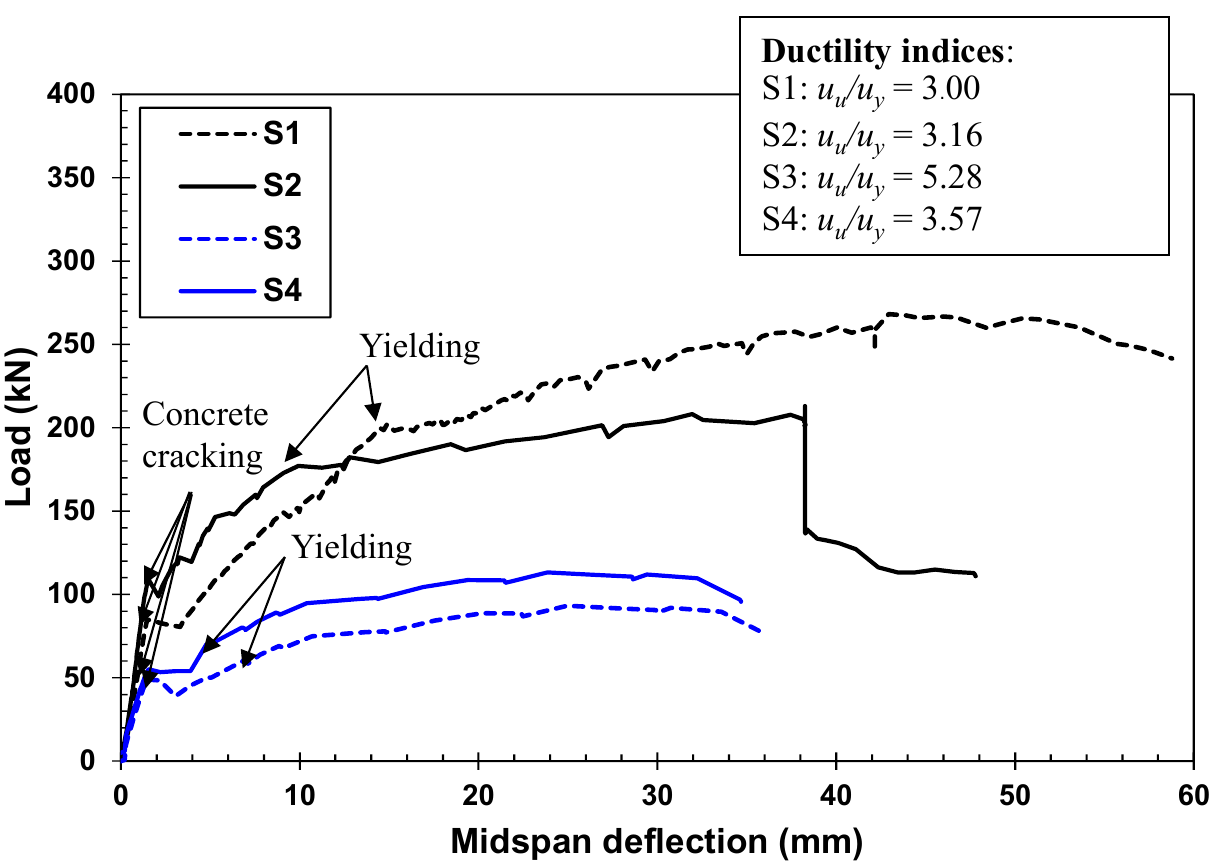
Figure 5. Load-displacement curves of tested composite decks. Table 2. The experimental results of the tested composite decks.